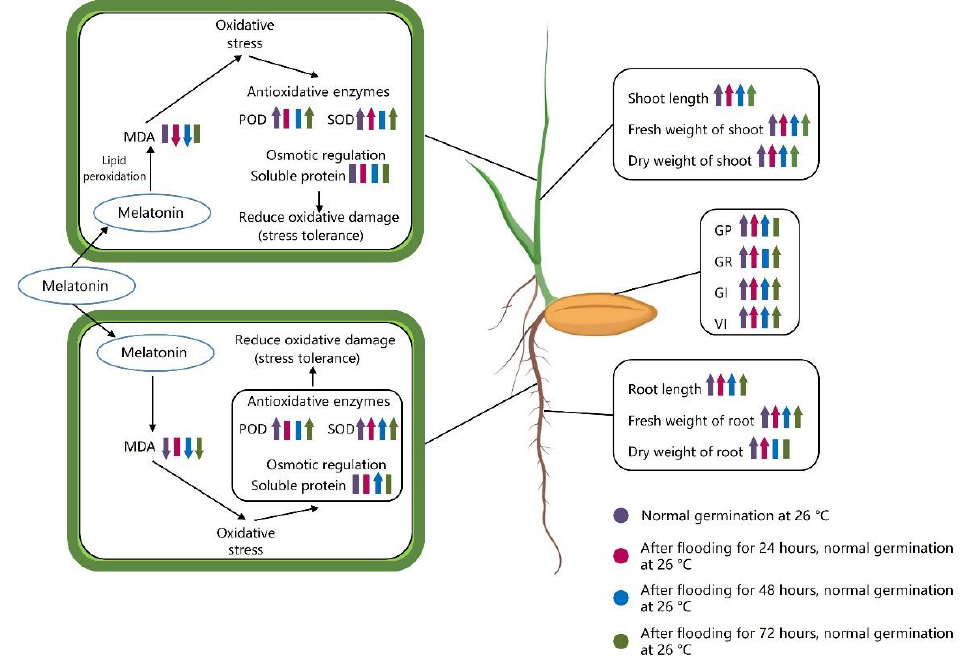
Figure 10. Regulatory pathways of 100 µM melatonin concentration on seed germination and seedling physiological indices under flooding stress. The symbols ↑ , ↓ , and | represent upregulation, downregulation, and no significant changes in various parameters, respectively.